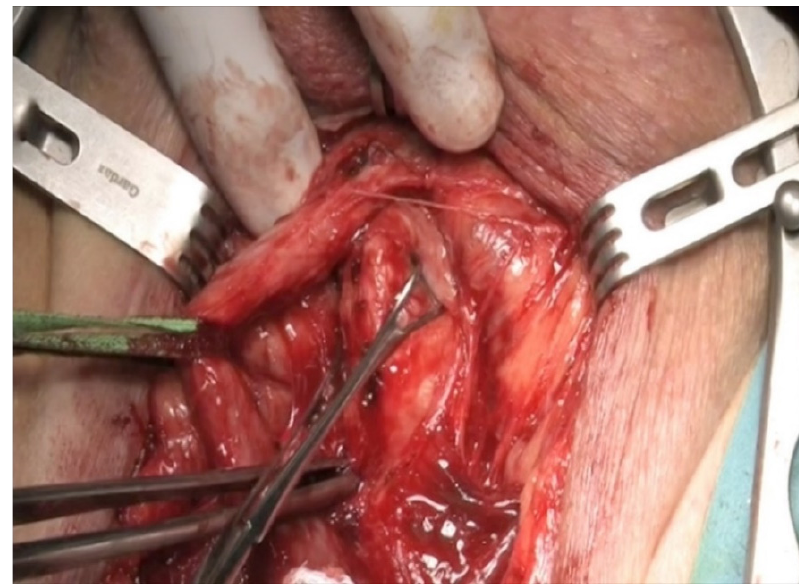
Figure 1. Urethral mobilization.